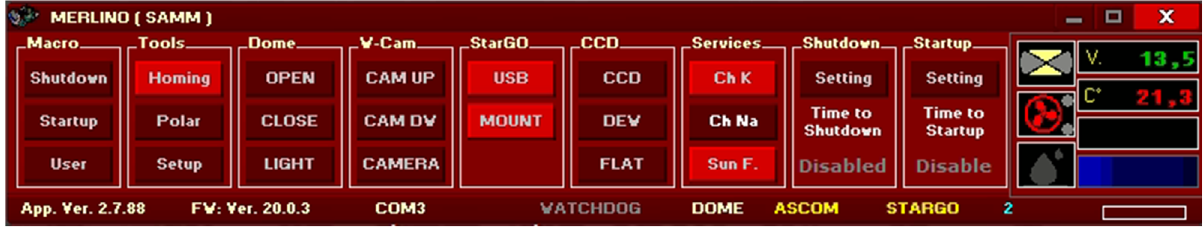
Fig. 7. The Merlino GUI.